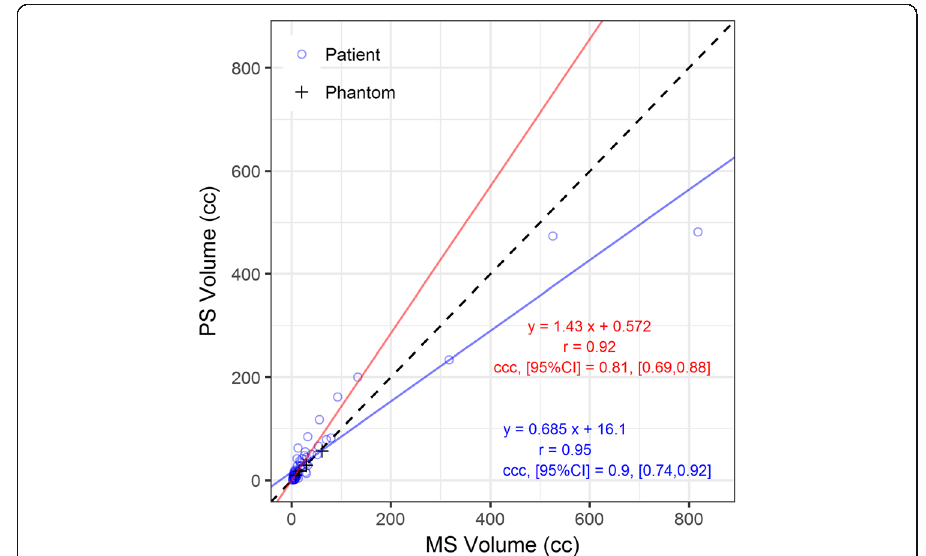
Fig. 6 Plot comparing PS volumes with MS volumes for 58 tumors. Blue fit line includes all lesions and the red fit line excludes 3 lesions > 200 cm 3 . The dashed line is the line of equivalence, and the black crosses represent our phantom